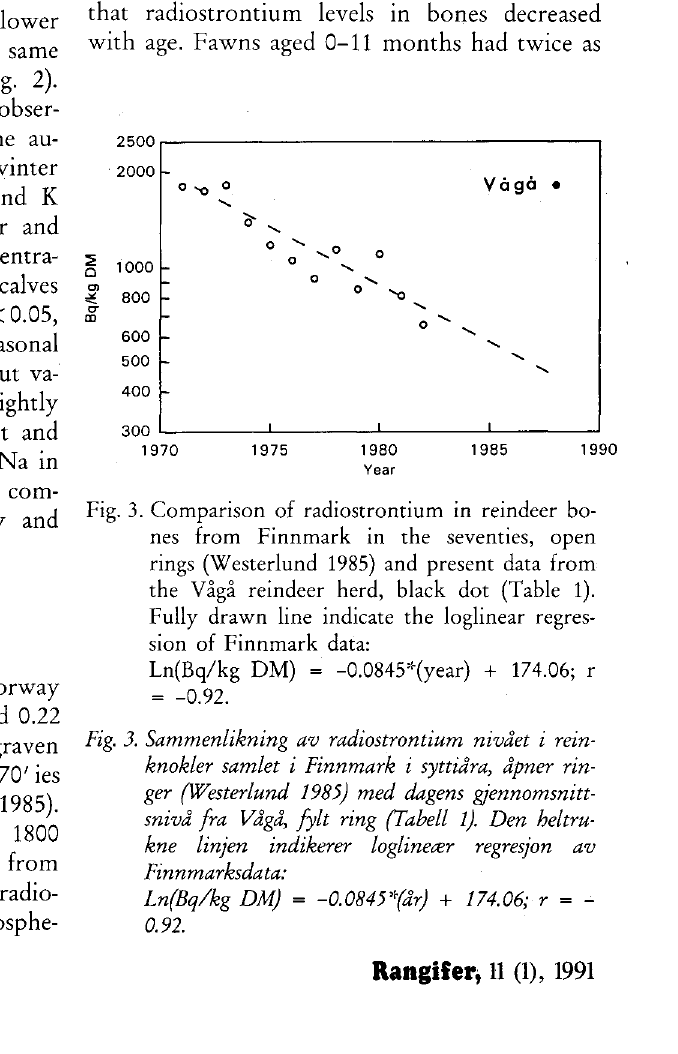
Fig. 3. Sammenlikning av radiostrontium